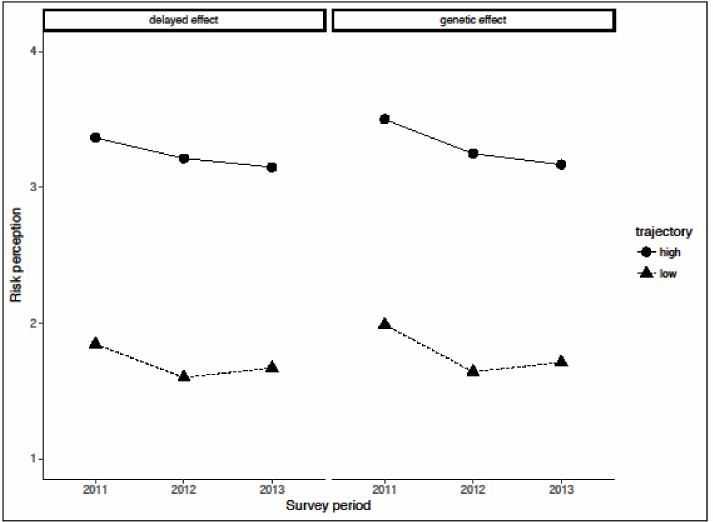
Figure 2. Trajectories of risk perception for the delayed and genetic effects. High group = risk perception score of 3 or more at all three time points; Low group = risk perception score of 2 or less at all three time